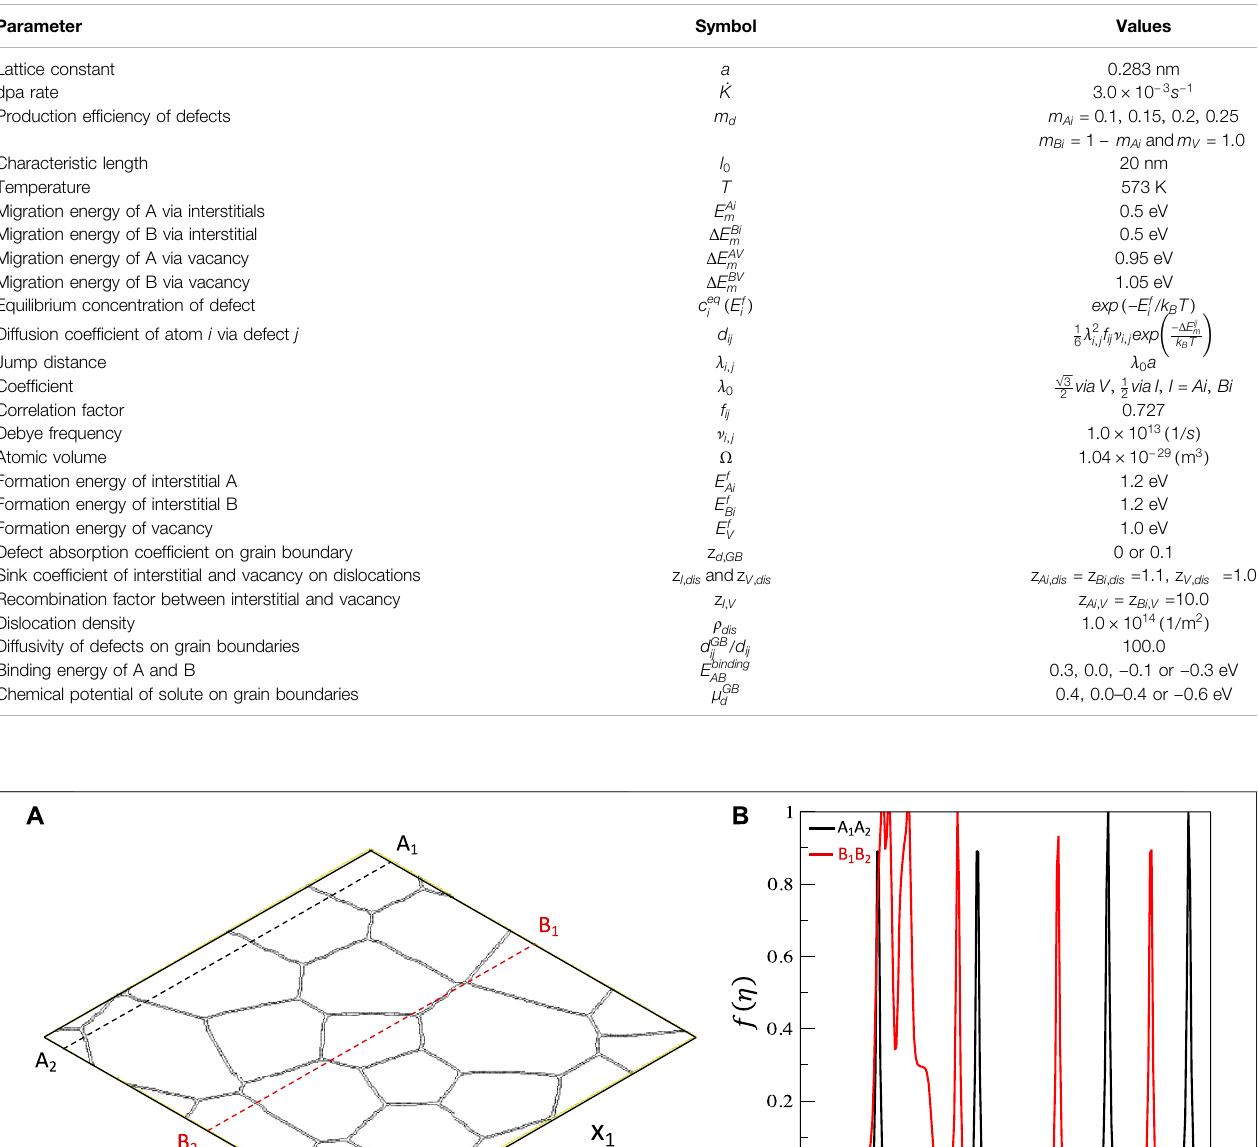
Frontiers in Materials |